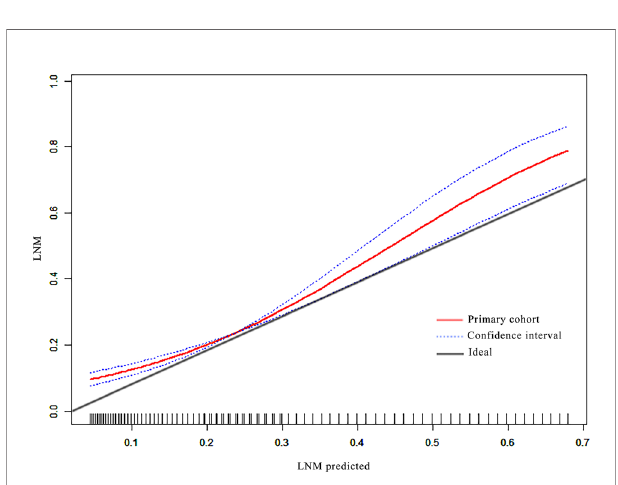
FIGURE 3 | The calibration curves of the nomogram in the primary cohort.